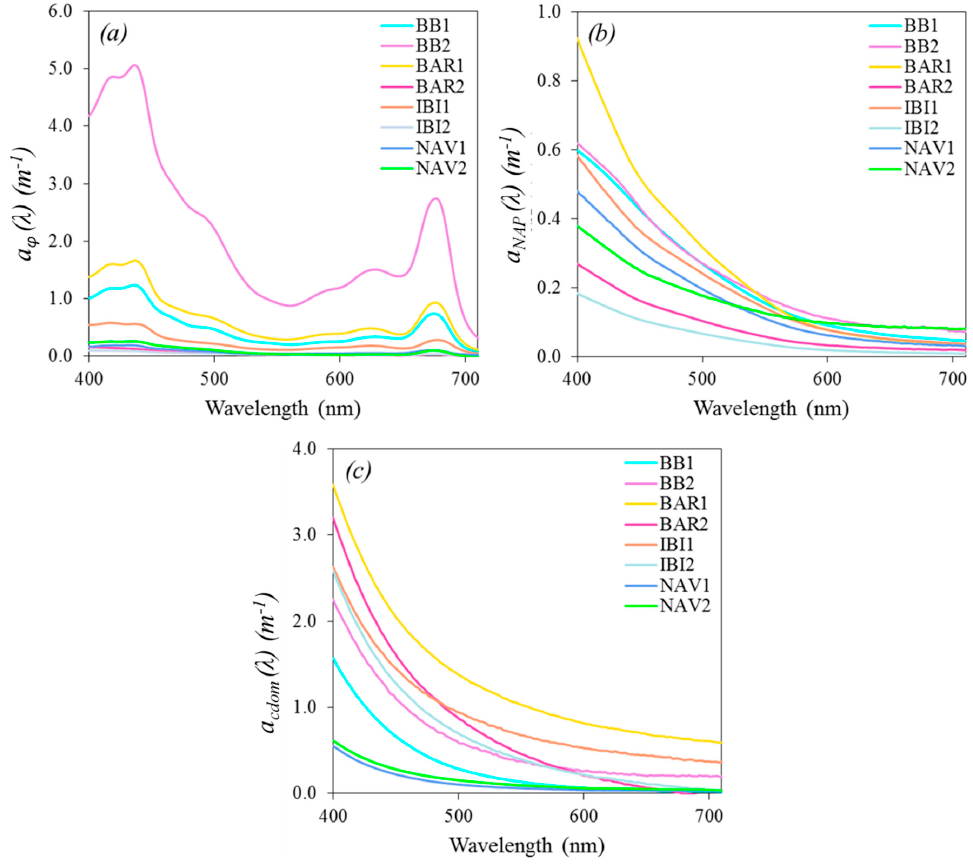
Figure 5. Average absorption spectra of ( a ) a φ ; ( b ) a nap ; ( c ) a cdom from all of the field surveys and respective optically active compounds (OACs).